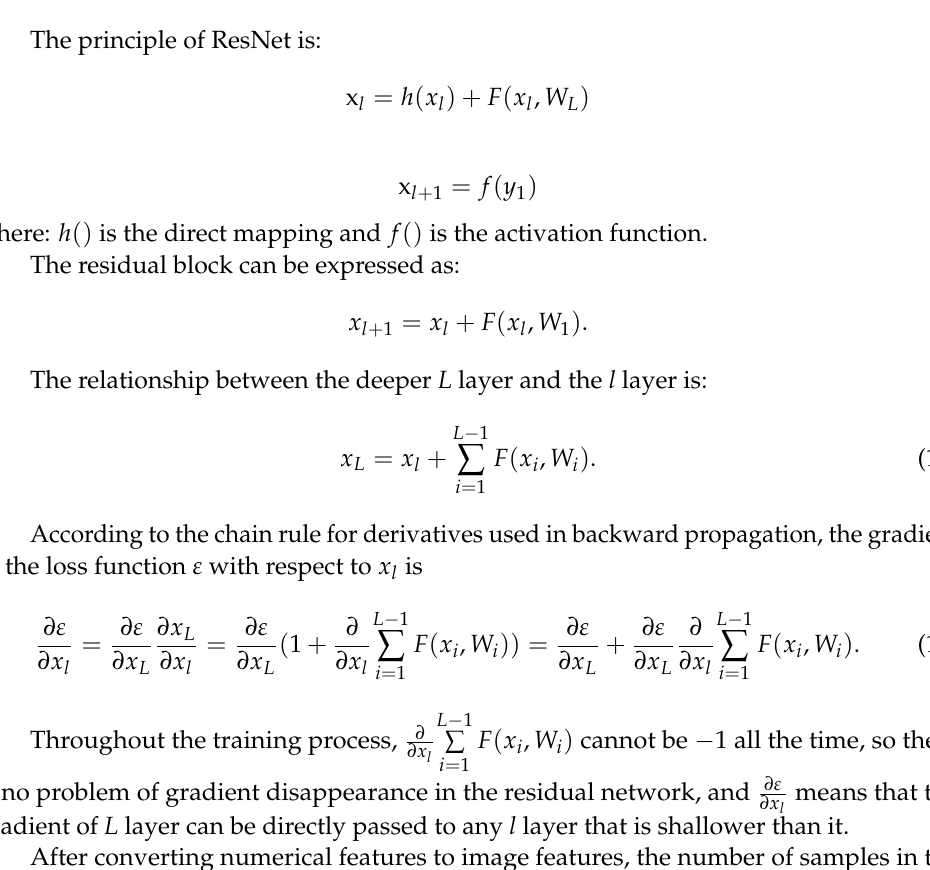
Figure 5. ( a ) Standard network structure diagram. ( b ) ResNet structure diagram.